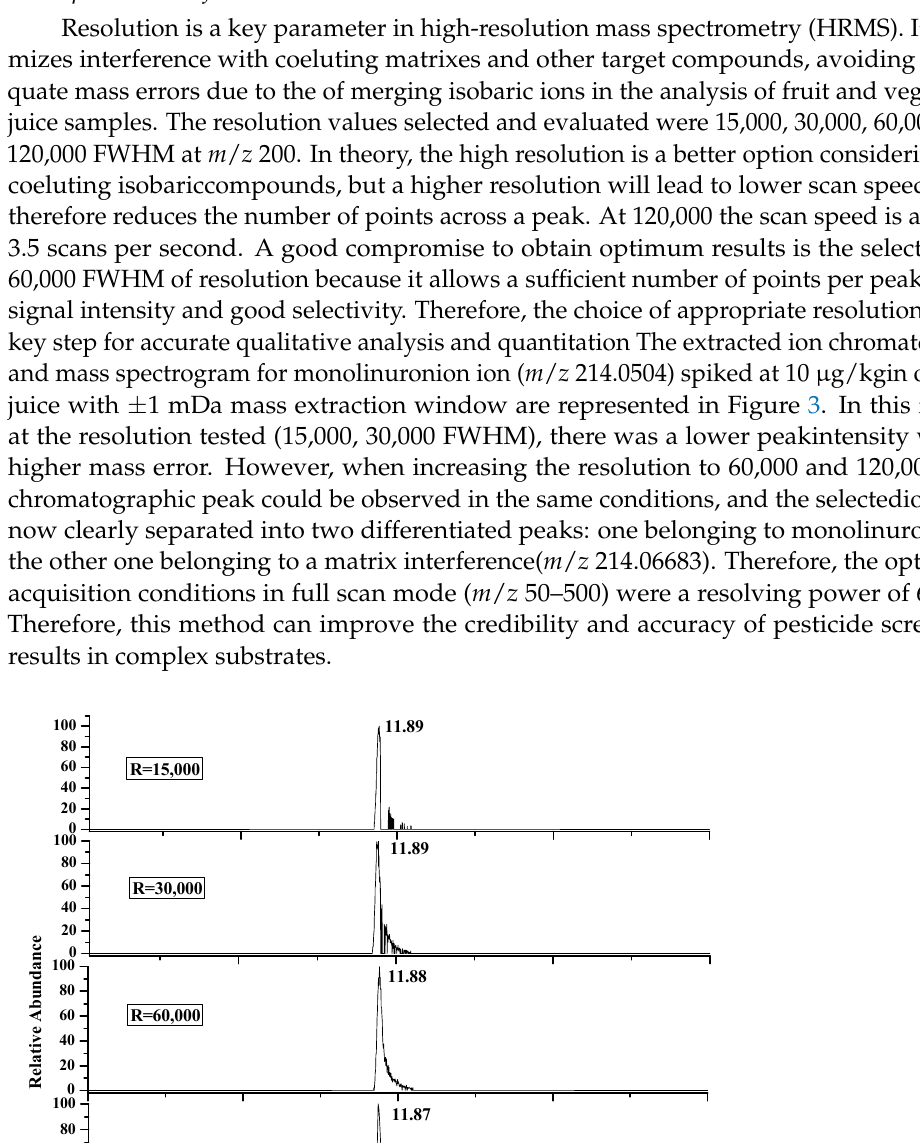
Figure 3. Extracted ion chromatograms andquality accuracy of the spiked (10 μ g/kg) monolinuron qualitative ion (214.0504) in the orange juice sample at different resolutions. 3.4. Qualitative Screening and Confirmation For identification the requirements of SANTE/12682/2019 werefollowed, which means that the relative intensities or ratios of selective ions, expressed as a ratio relative to the most intense ion, which are used for identification, should match with the refer- ence ion ratio [38]. For accurate mass measurement/high resolution mass spectrometry, the variability of ion ratios is not only affected by S/N of the peaks in the extracted ion chromatograms, but may also be affected by the way fragment ions are generated, and by the matrix. For this reason, no generic guidance value for ion ratio can be given. Due to the added value of accurate mass measurement, matching ion ratios are not necessary. However, they may provide additional support for identification. Besides, document also sets requirements with respect to retention time deviations ( ≤ ±0.1 min from reference re- tention time) and mass deviations ( ≤ ±5 ppm). All the 350 target compounds can be iden- tified accurately by using the database established in this paper.Mass error, total ion chromatogram, and multiple extracted ion chromatograms of 350 pesticides spiked in the